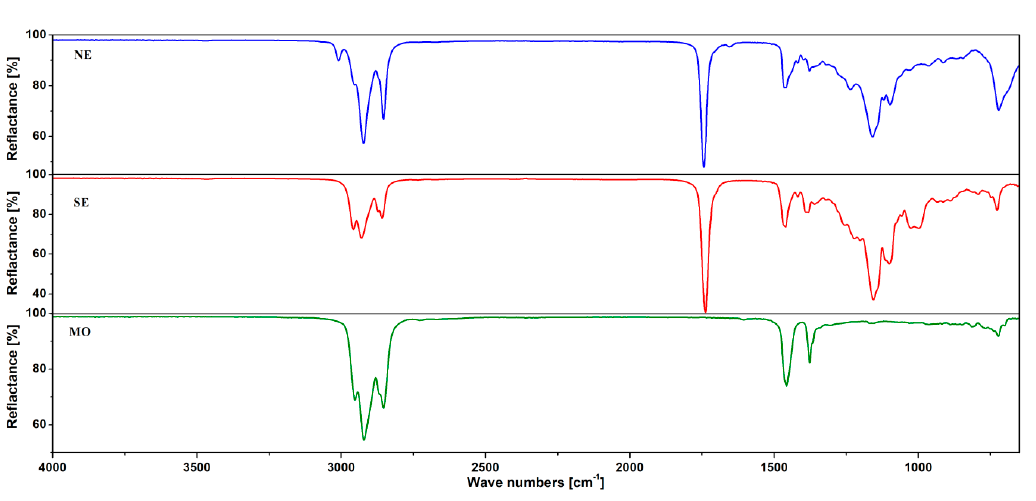
Figure 5. Attenuated total reflectance-Fourier transform infrared (ATR-FTIR) spectra of investigated dielectric liquids at room temperature (25 °C).